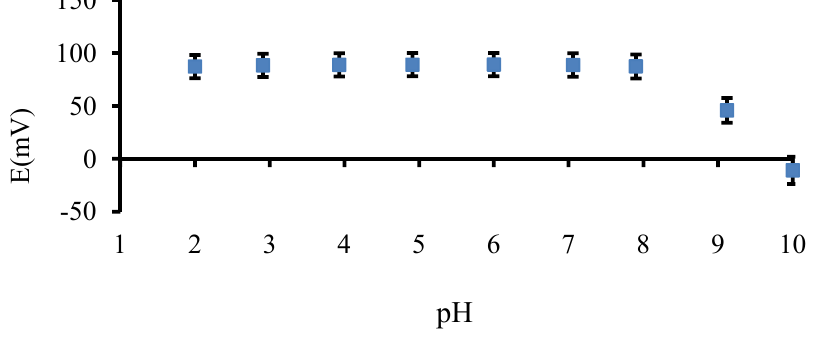
Figure 4. Effect of pH on the potential response of lidocaine sensors. Mean ± SD values are shown ( n =